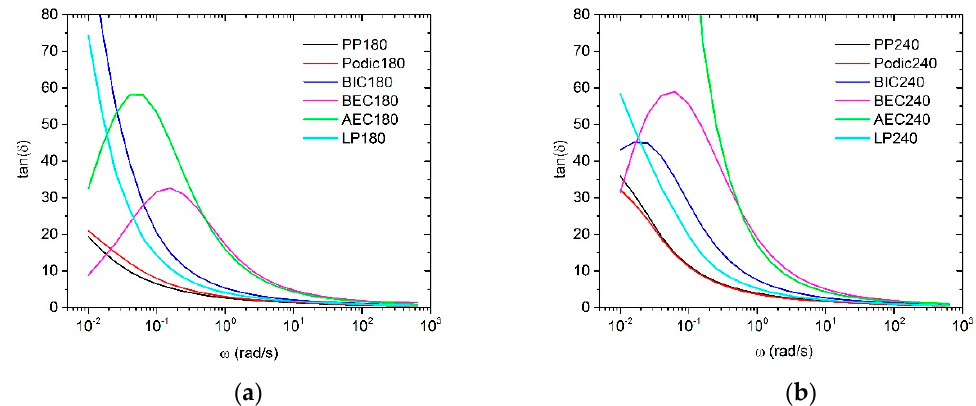
Figure 6. tan δ of the unmodified and modified PP with extrusion temperature of ( a ) 180 °C and ( b ) 240 °C; measured at 230 °C.